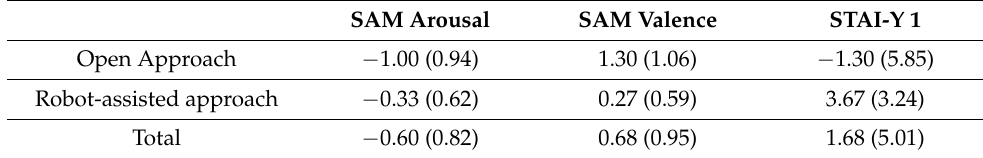
Table 3. Means and standard deviations (in parentheses) for SAM dimensions and STAI-Y delta scores.